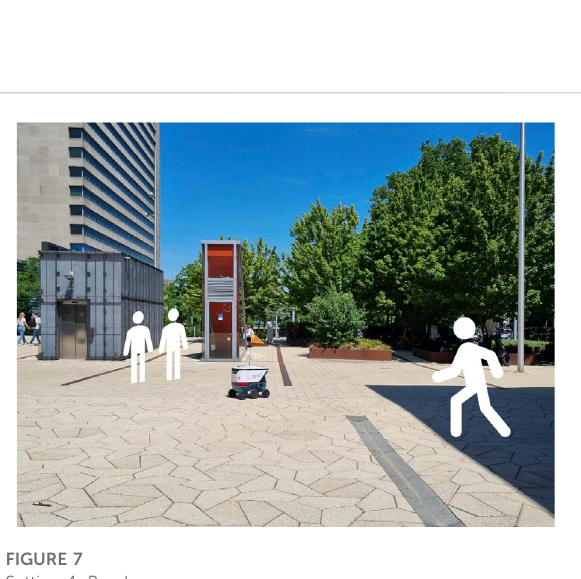
FIGURE 7 Setting 4: